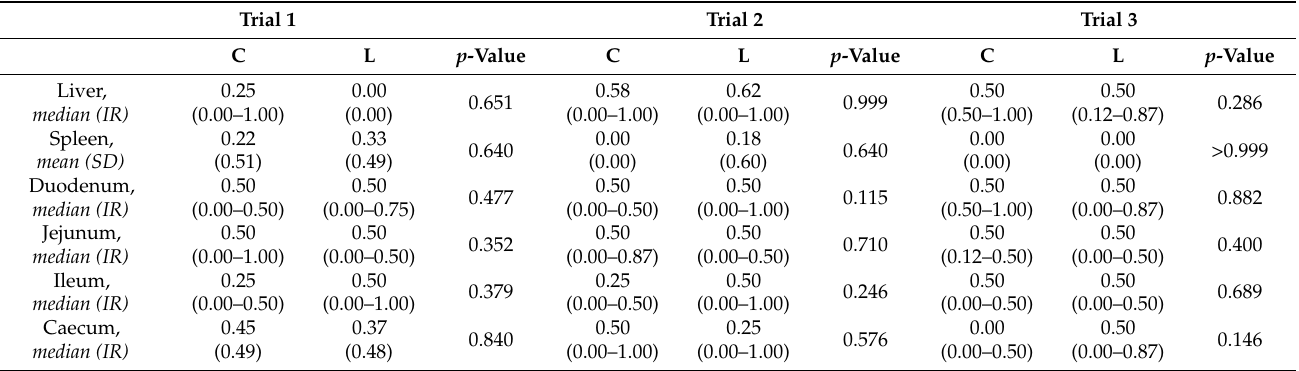
Table 6. Histopathological alterations of the main organs between control and probiotic group of trial 1, 2 and